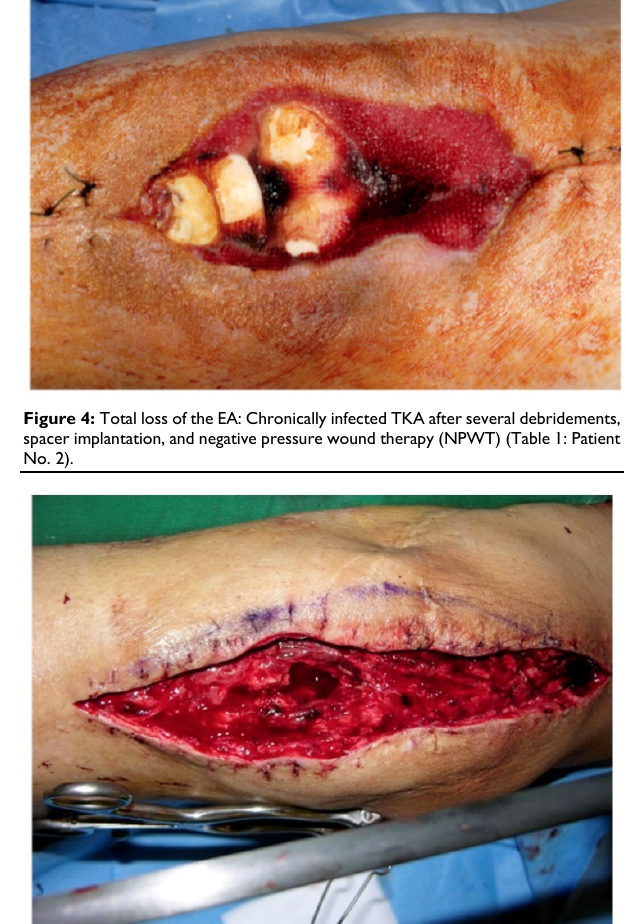
Figure 5: Partial loss of the EA: PJI of the right knee with a 70% patellar tendon lesion after secondary TKA in an area with excessive scarring. Previously, this patient had undergone 20 operations because of chronic osteomyelitis after a complex comminuted fracture of the right femoral shaft after being hit by a car as an adolescent. The TKA was removed followed by debridement, application of an external fixator, and soft-tissue reconstruction with a free sensate upper lateral arm flap before TKA reimplantation seven weeks later (Table 1: Patient No. 3; additional Figures 7, 8, 9, 18, and 19).